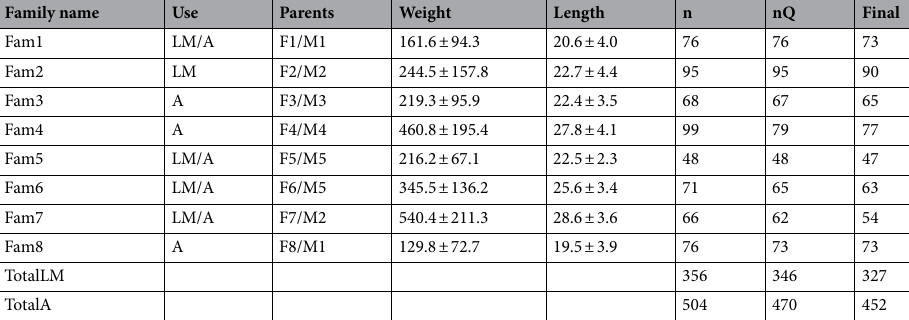
Table 1. Families used to construct the genetic linkage map (LM) and association study (A). Father (F) and Mother (M) of each family, the average weight and standard length at age 800 days and the number of specimens originally selected for analysis (n) are indicated. Moreover, the number of animals that passed that DNA quality analysis (nQ) and the final number of animals that passed after checking for Mendelian